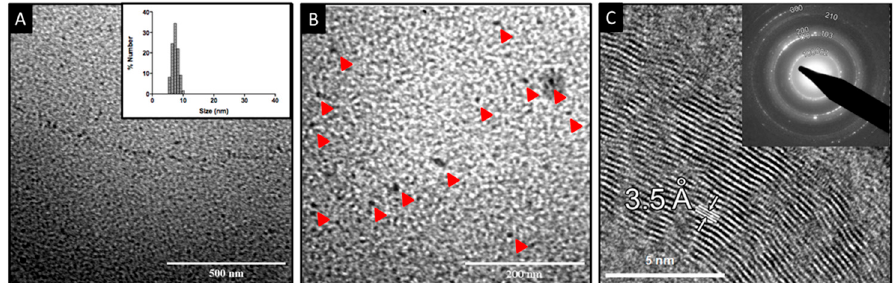
Figure 3. Electron microscopy characterization of NPs. ( A ) TEM image of biomimetic Cu 2 S NPs. The inset shows the size dispersion analysis through DLS. ( B ) TEM image of biomimetic Cu 2 S NPs (red arrows show the NPs). ( C ) HRTEM image obtained from the sample. A particular family of planes could be clearly distinguished from the micrograph. The corresponding interplanar distance is equal to 3.5 ± 0.1 Å. The inset in the ( C ) shows the ring diffraction pattern obtained for the sample.